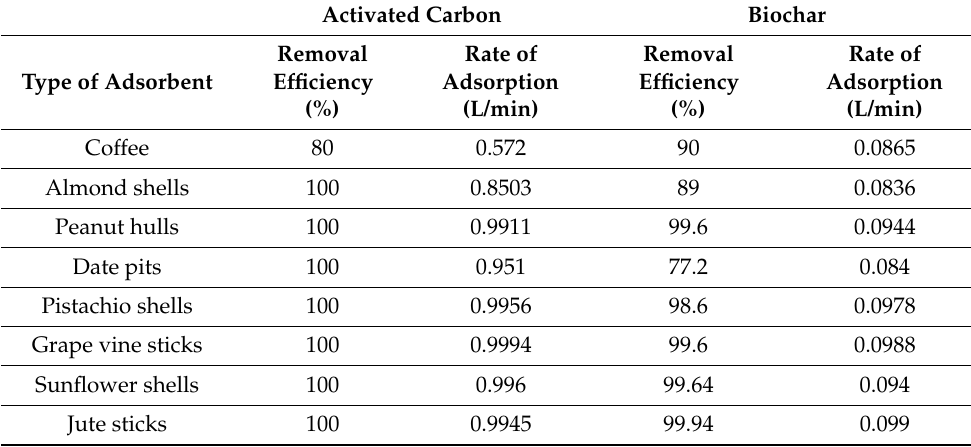
Table 12. Comparison of efficiency and maximum adsorption rate for activated carbon and biochar prepared using various natural plant wastes. Own compilation based on literature data [122].